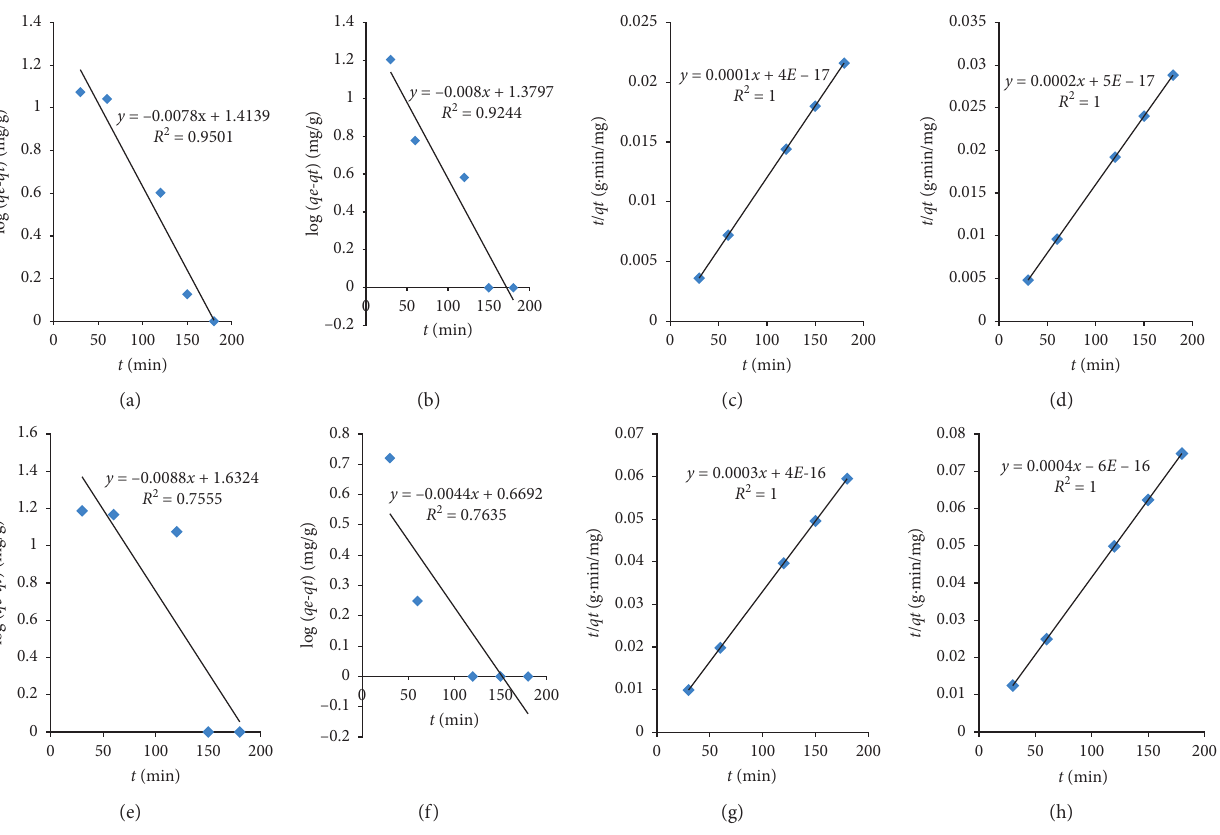
Figure 9: Linear plots of (a) pseudo-first-order and (b) pseudo-second-order for Cd 2+ adsorption by ATK and (c) pseudo-first-order and (d) pseudo-second-order for Cr 6+ adsorption by ATK. Linear plots of (e) pseudo-first-order and (f) pseudo-second-order for Cd 2+ adsorption by UTK and (g) pseudo-first-order and (h) pseudo-second-order for Cr 6+ adsorption by